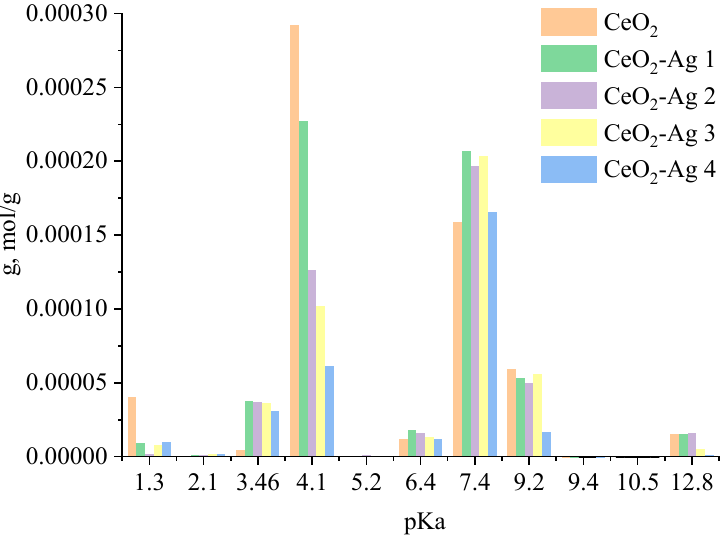
Figure 6. Acid-base properties of CeO 2 -Ag nanocomposites.